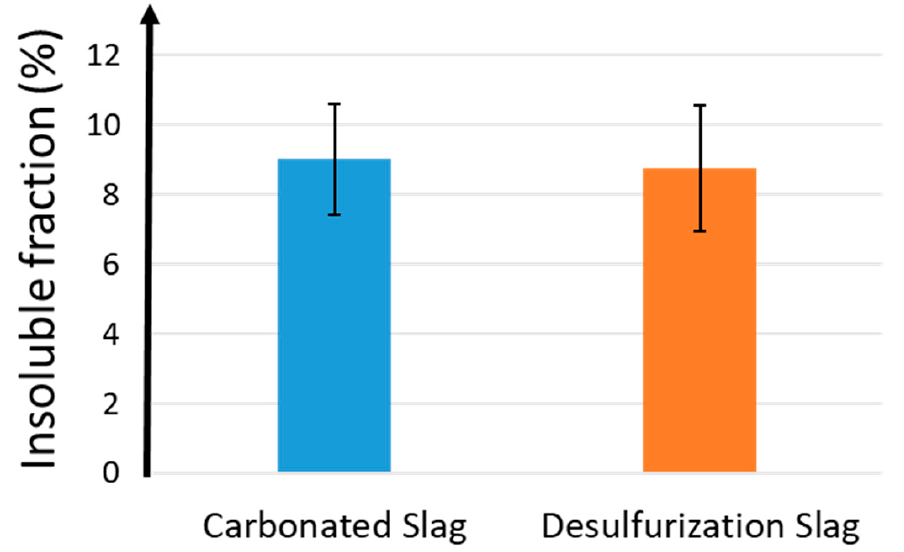
Figure 6. Insoluble fraction after HCl test of c-BOF and De-S slags.